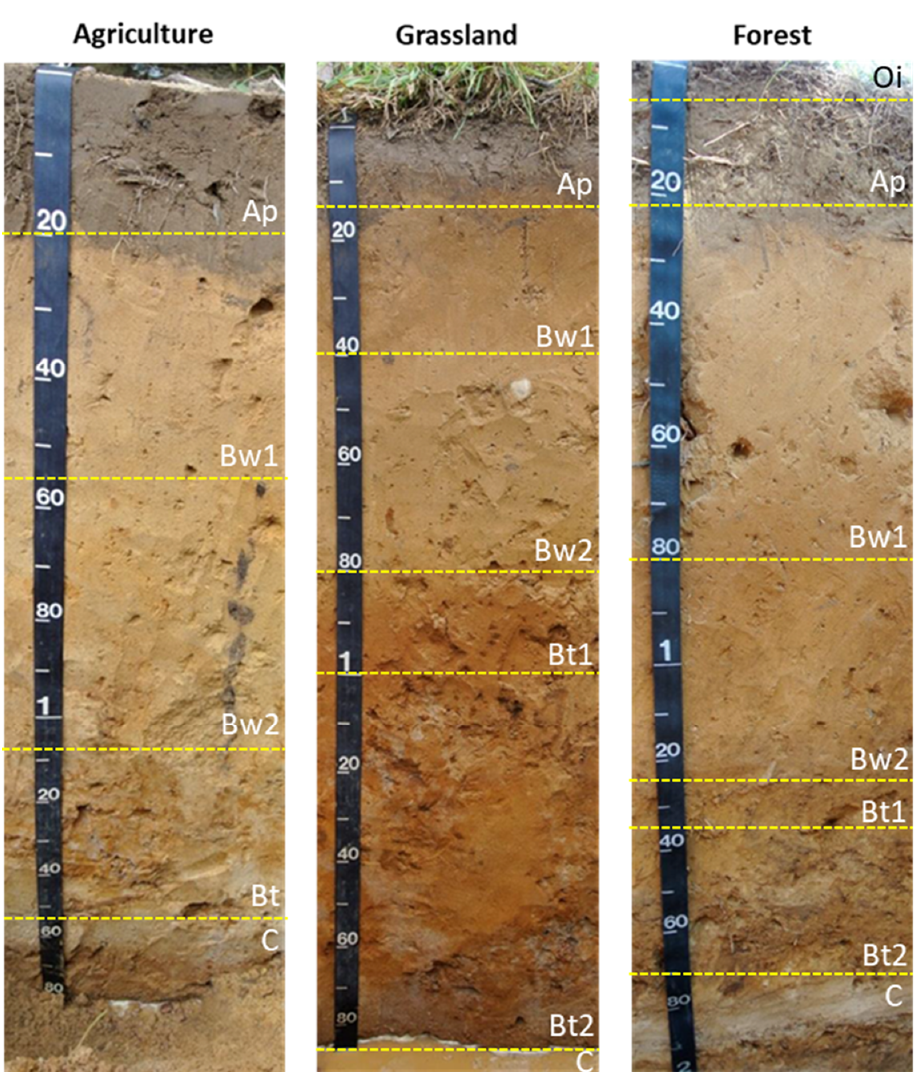
Figure 1. Horizonation of three sandy Alfisols (loamy, mixed, superactive, mesic Arenic Hapludalfs) under different land use in the Central Sand Plains of Wisconsin, USA.